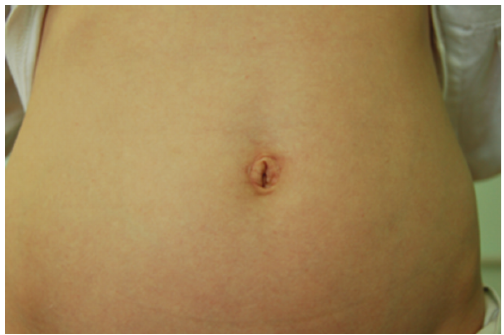
Figure 2: Clinical photograph of a 17-year-old patient 3 months following a SILS appendicectomy. Residual oedema of the superior aspect of the umbilicus is still